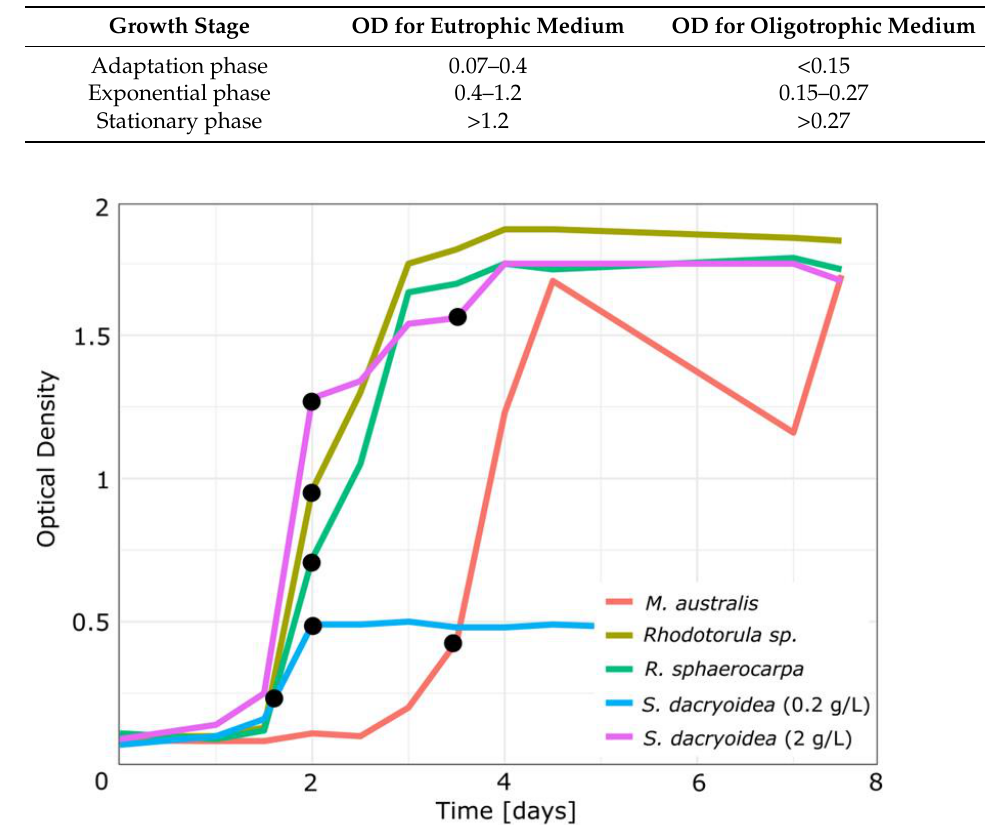
Table 3. Optical density (OD) of different fungal growth stages.